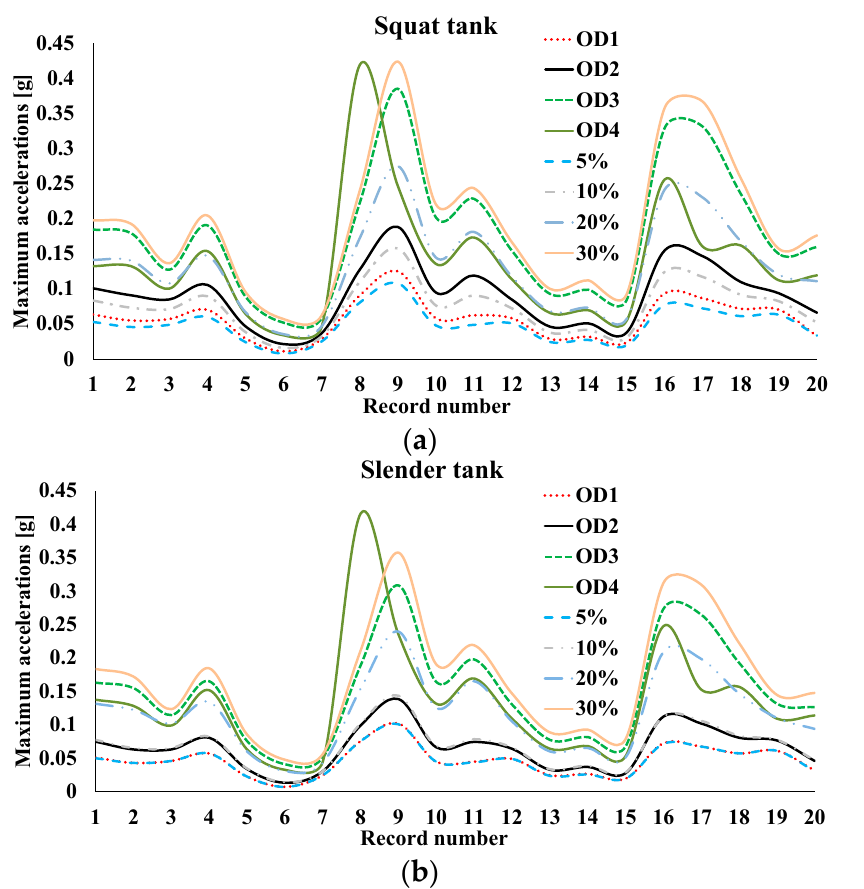
Figure 6. Accelerations at the tank base for: ( a ) the squat and ( b ) slender geometry.